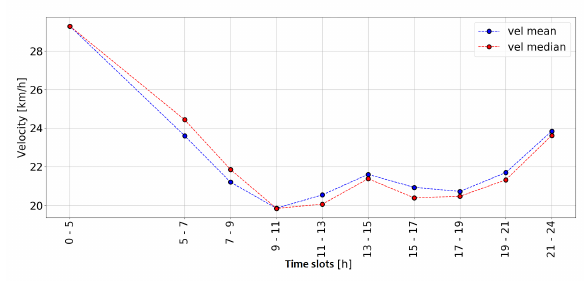
Figure 11. Line 39: time slot velocities in weekend days.